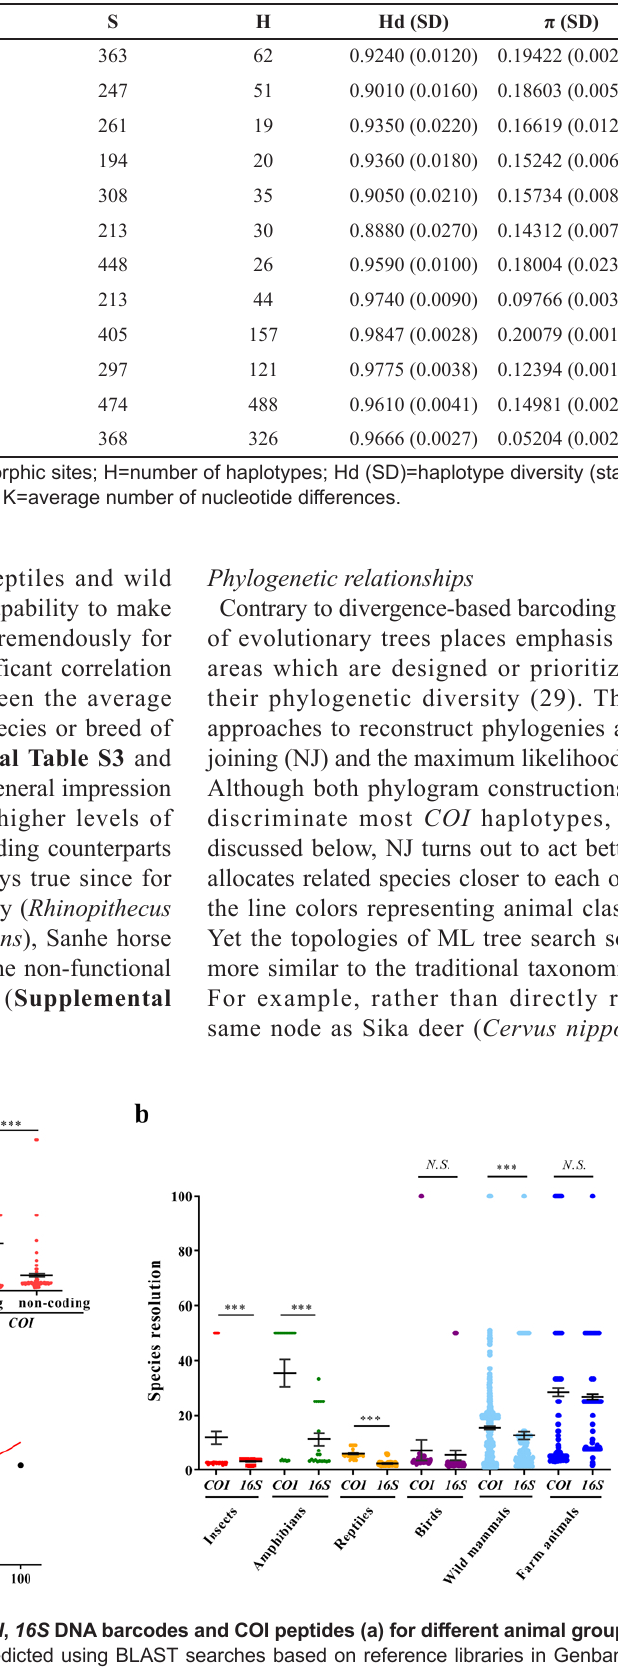
Table 2. Genetic diversity of COI and 16S barcodes generated in the present study.